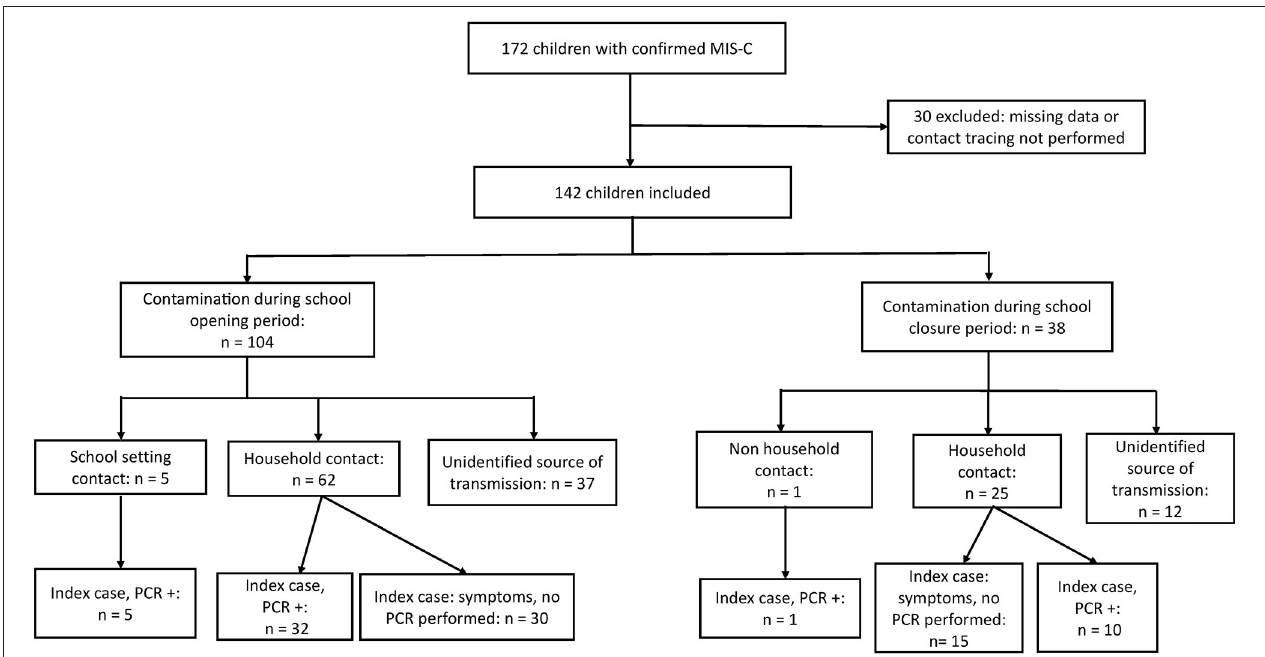
FIGURE 1 | Flow chart of the study participants. MIS-C, multisystem inflammatory syndrome in